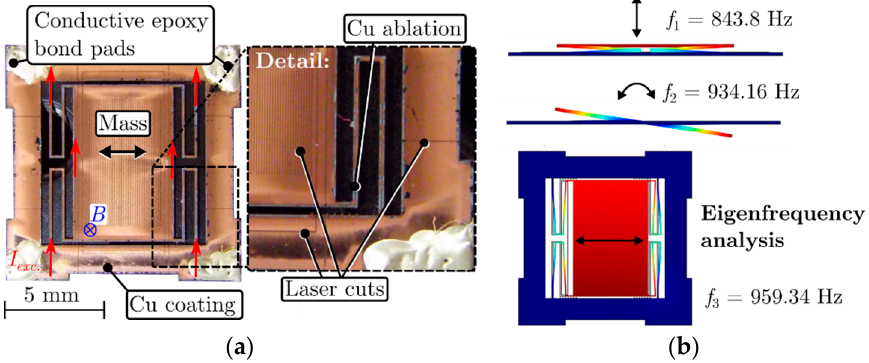
Figure 1. ( a ) The manufactured glass magnetometer coated with copper and conductive epoxy bond pads. The copper on the mass was removed by a laser, yielding slits of 10 µm width, which shall guide light through the glass for a future application such as optical detection of modulated light flux. Further, laser cuts on the outer frame interrupts the conductive layer which force an externally applied current over the springs and, hence, over the sensing mass. ( b ) Simulation results with the frequency of interest at 959.34 Hz ( f 3 ).